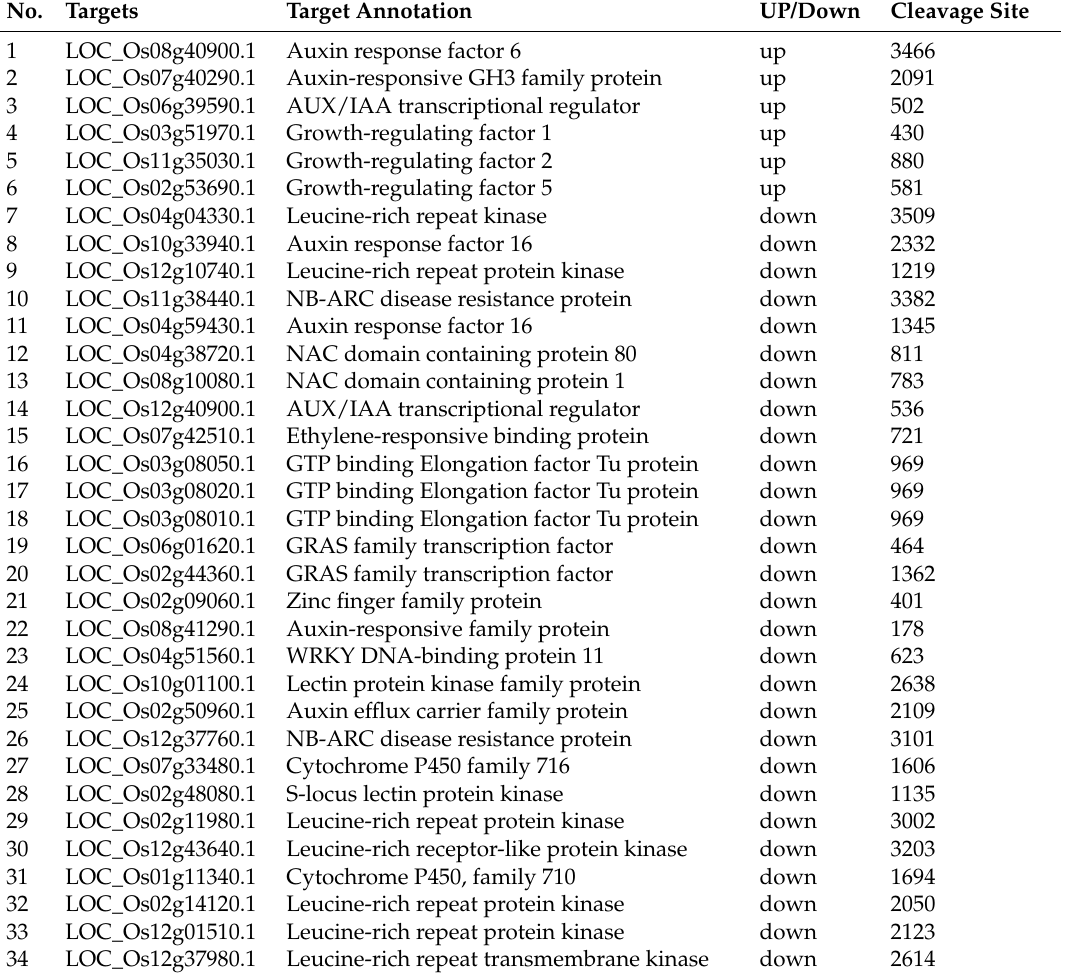
Table 2. The identified targets involved in rice defense responses by degradome